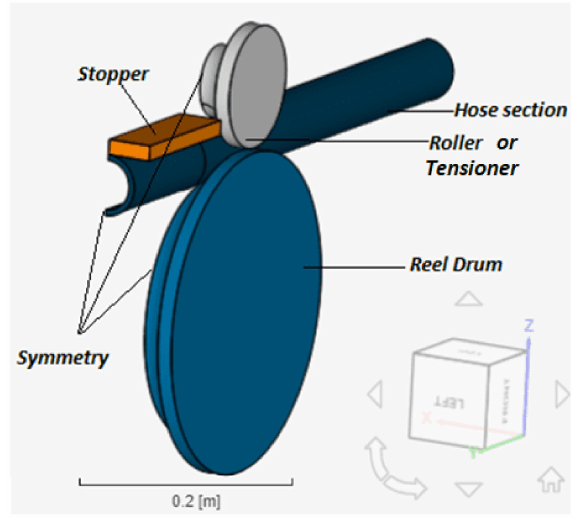
Figure 5. The details for the FEA of bending tubular pipe model, in Simscale.